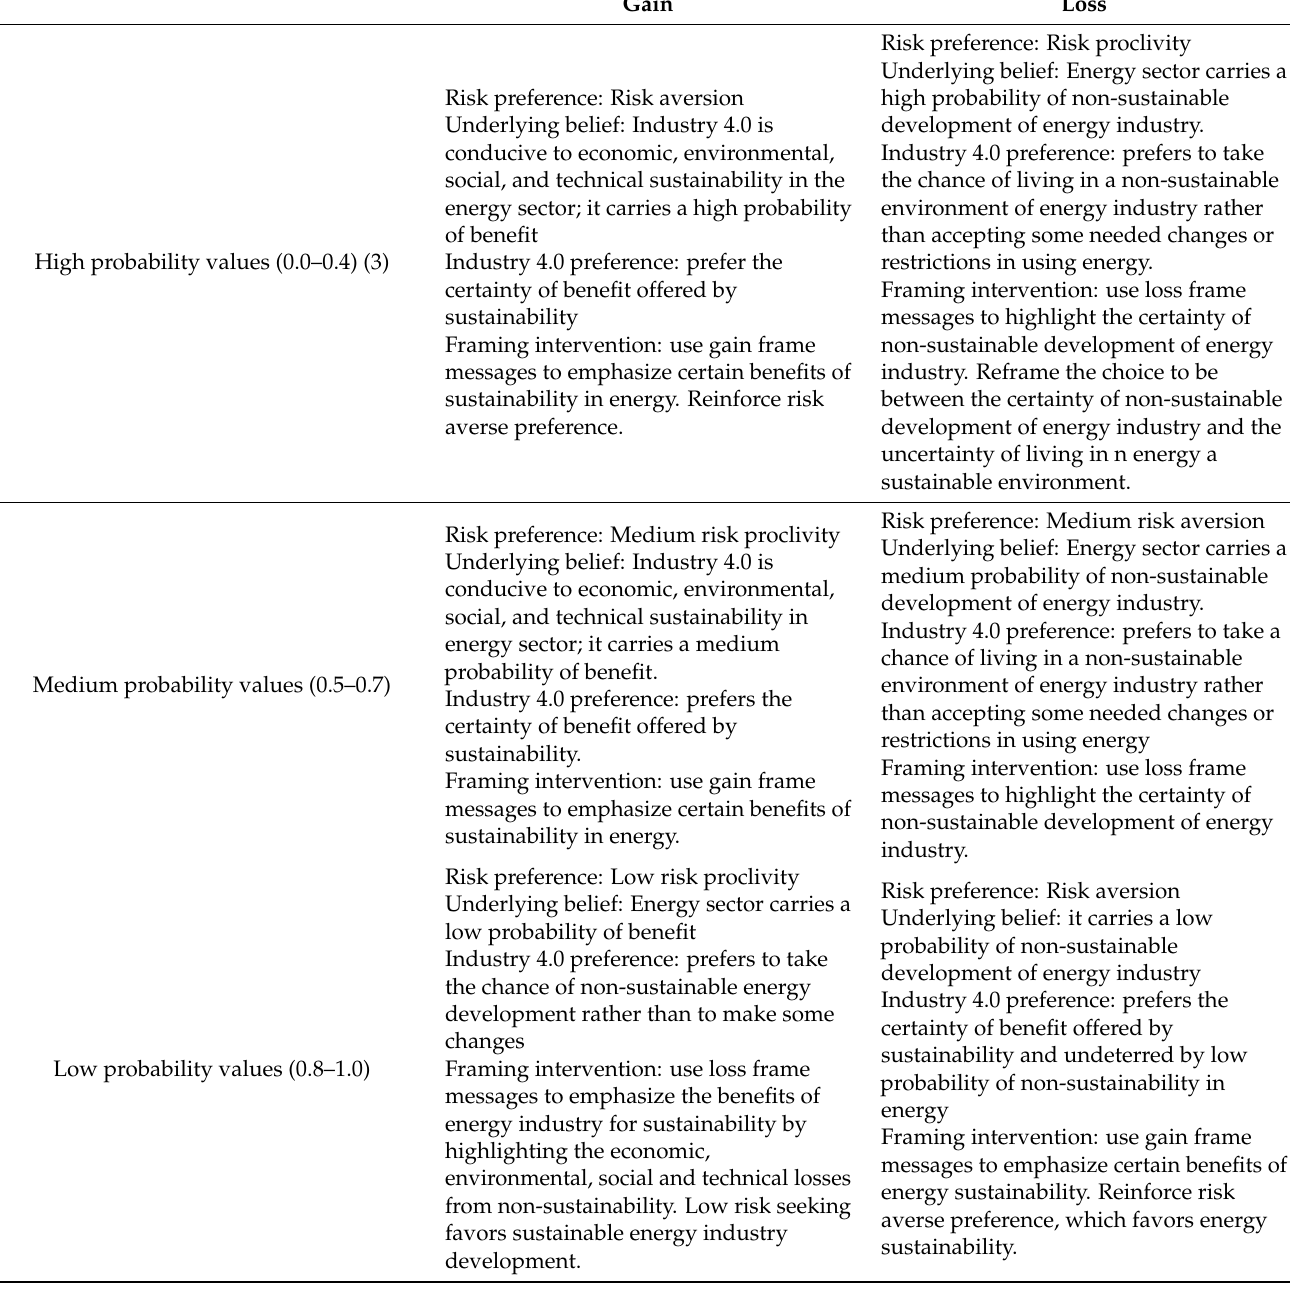
Table 9. Typical people’s attitude toward risk of gains and losses in the light of Industry 4.0 for energy sustainability (from the PT perspective). Gain Loss